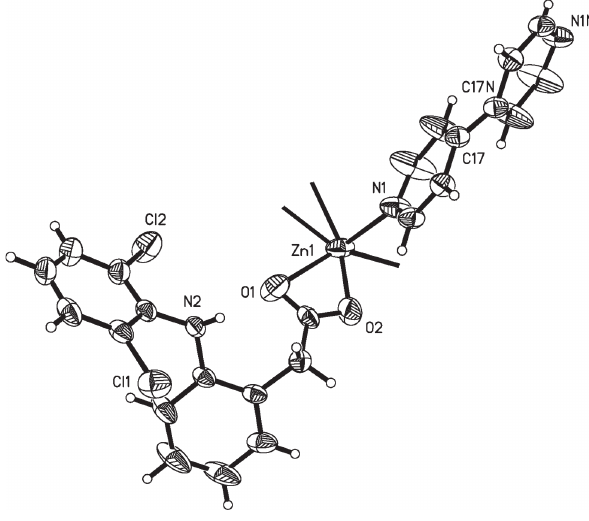
Table 1: Data collection and handling.